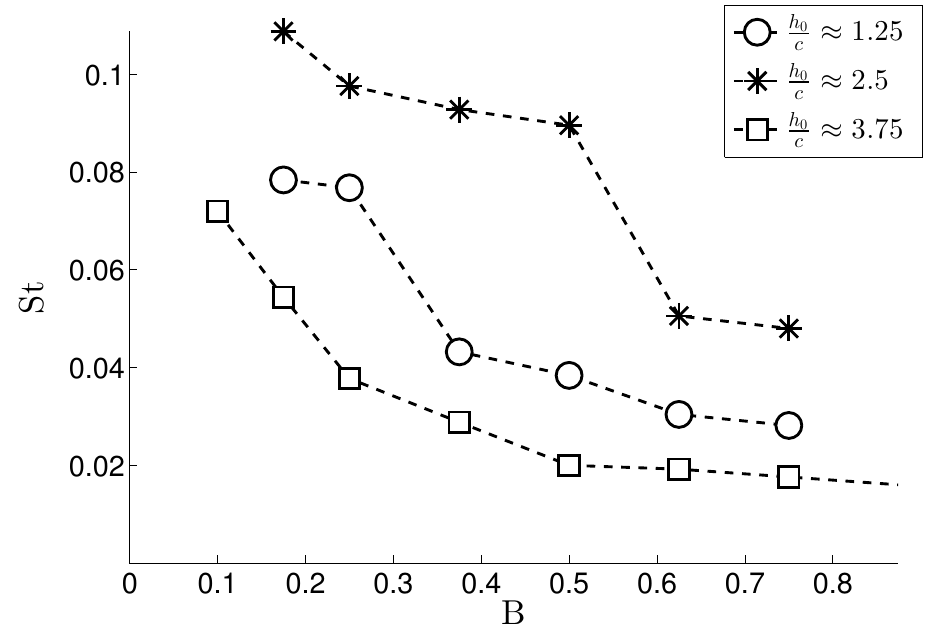
Figure 11. Re = 1000: St vs. B for different values of h 0